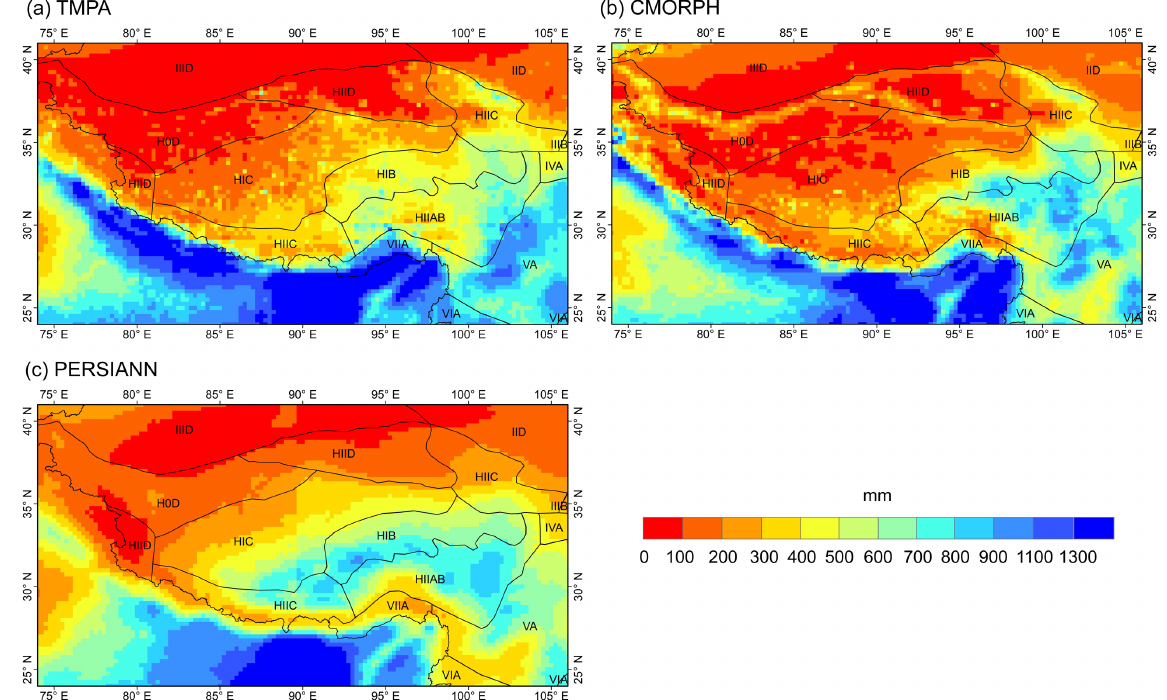
Fig. 3. The 6yr mean rainy season precipitation during 2004–2009 for (a) TMPA, (b) CMORPH and (c)